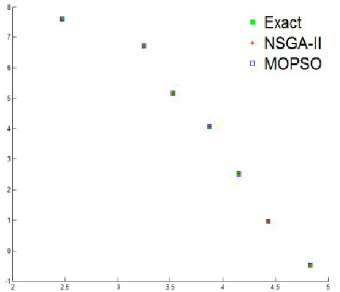
Fig. 3. Extracted non-dominated solutions by different approaches for permutation problem with 4 alternatives